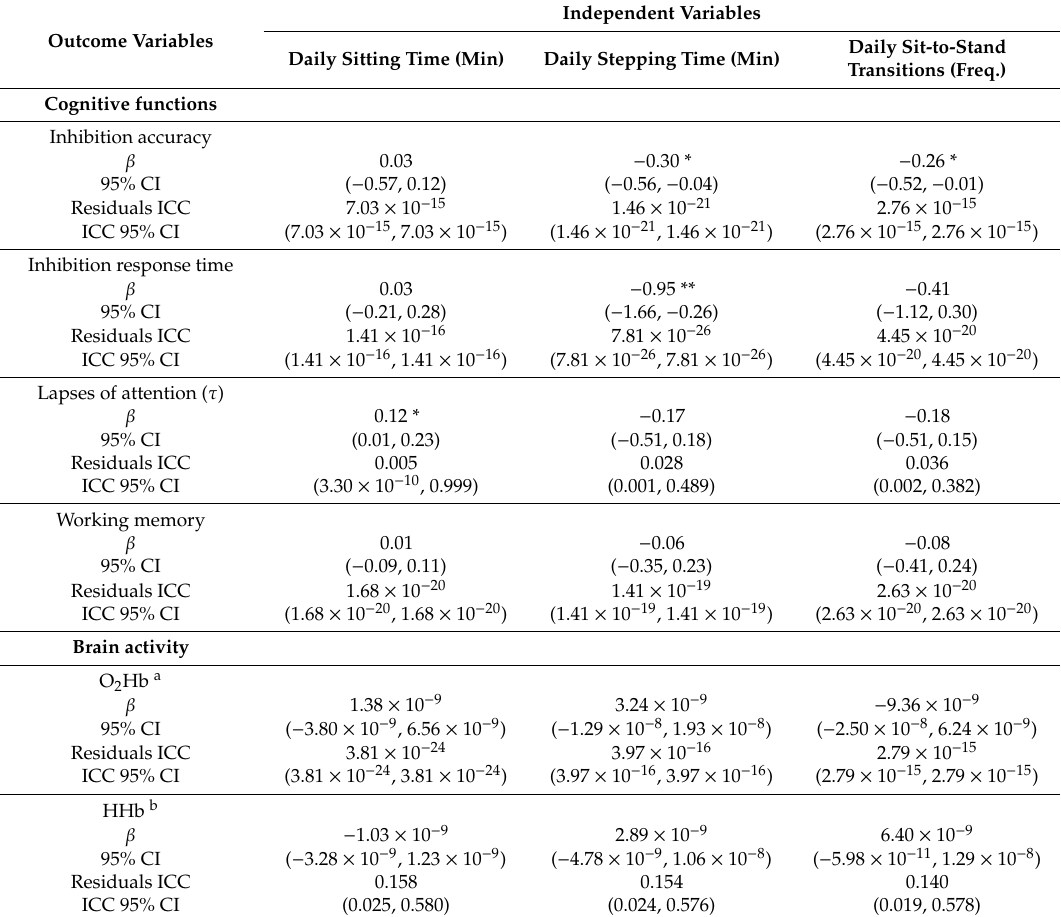
Table 3. Mixed model results regarding associations between daily sitting, stepping and sit-to-stand transitions and the cognitive and brain activity outcome variables—adjusted for sex and